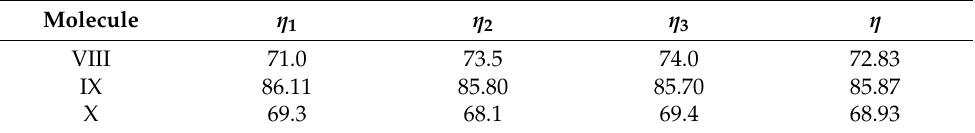
Table 5. Yields for the experiments in the middle of the variation domain.